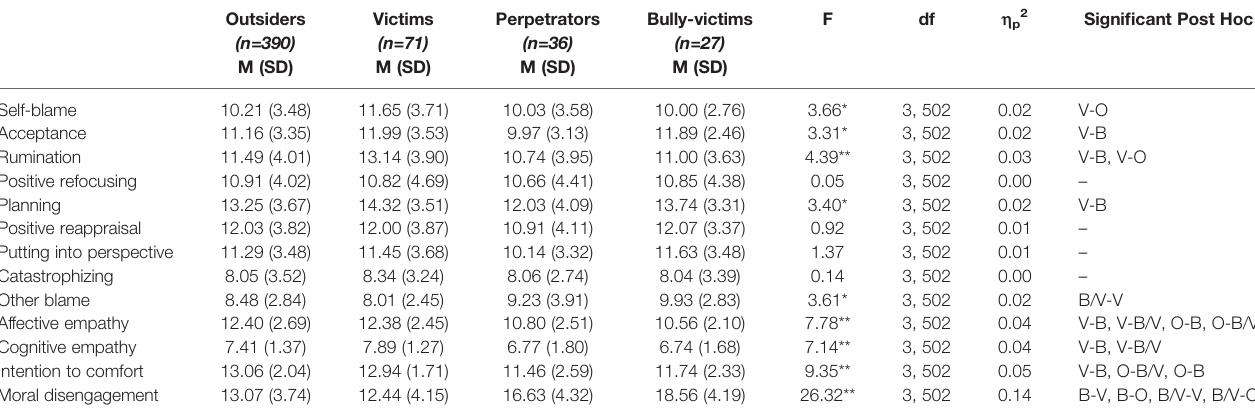
TABLE 3 | Results of multivariate analyses of variances